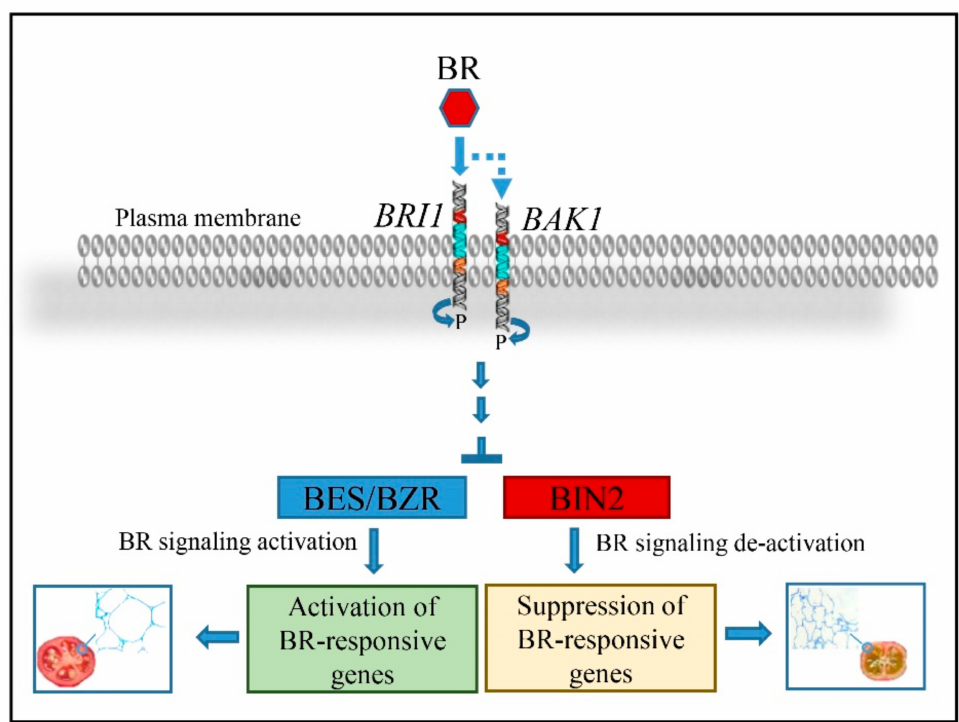
Figure 7. Proposed BR-signaling pathway involvement in tomato fruit size regulation. BRs attach to Bri1 ( Slcurl3 ) initiating the BR-signaling cascade. BES / BZR transcription factors binds with BR- responsive genes and activates cell expansion. Bin2 acts as BES / BZR inhibitor and subordinates the BR-signaling strength thus affecting the fruit developmental